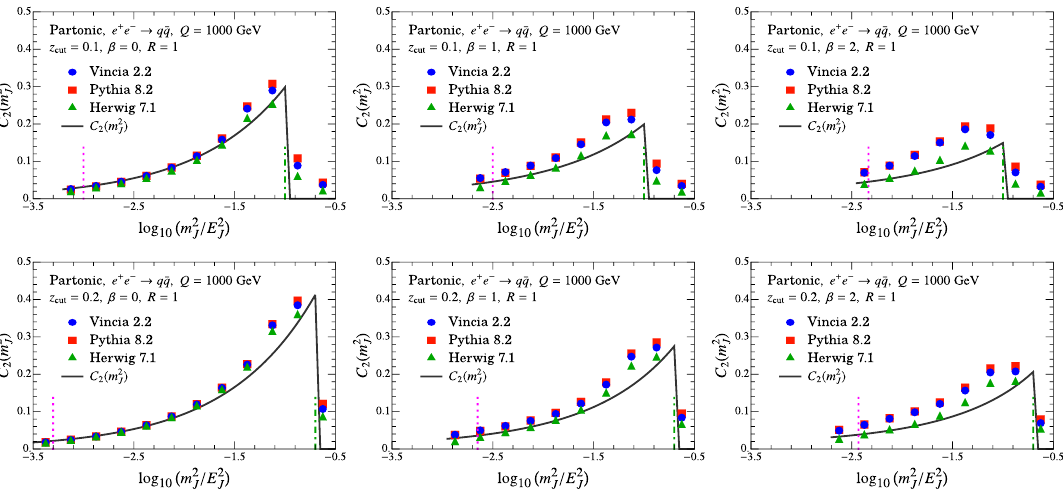
Figure 16 . Comparing our computation of C 1 ( m 2 (rows), (cid:12) = 0 ; 1 ; 2 (columns).